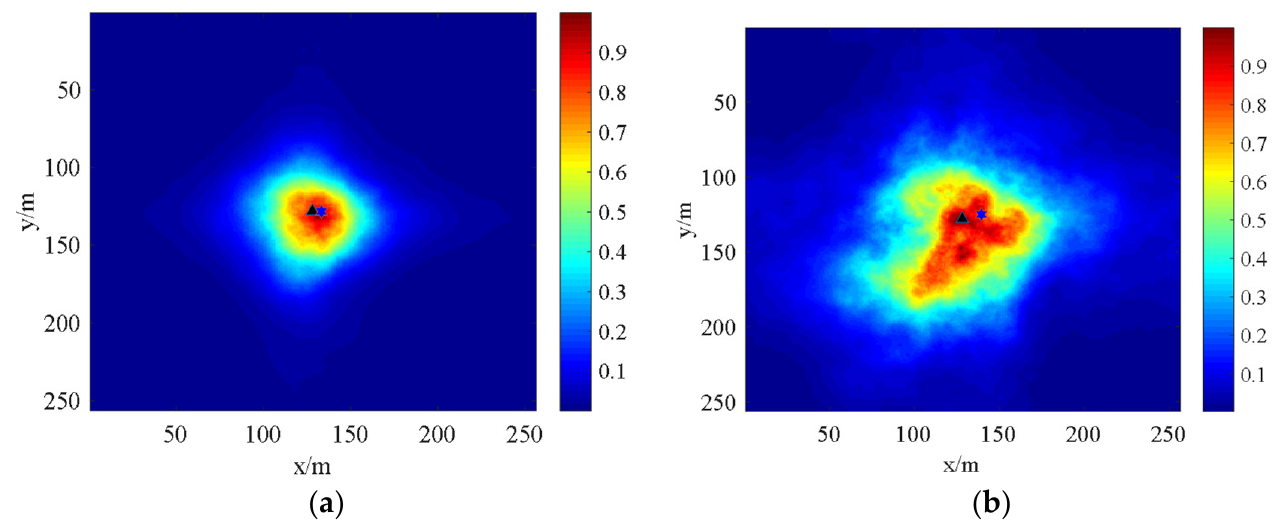
Figure 11. Spot drift phenomenon of laser transmission ( a ) ∆ z = 75 m, L = 2000 m, ( b ) ∆ z = 200 m, L = 2000 m.